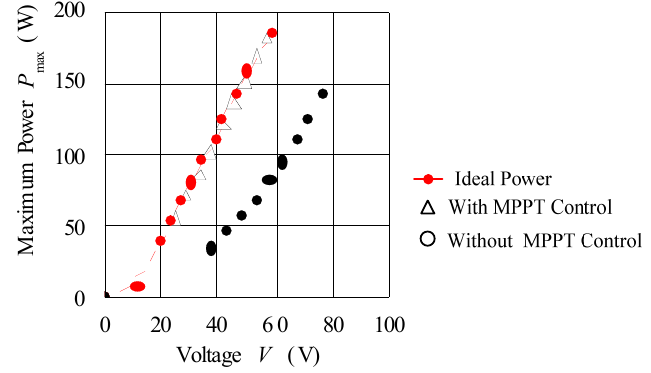
Figure 11. With and without the new estimator control strategy.